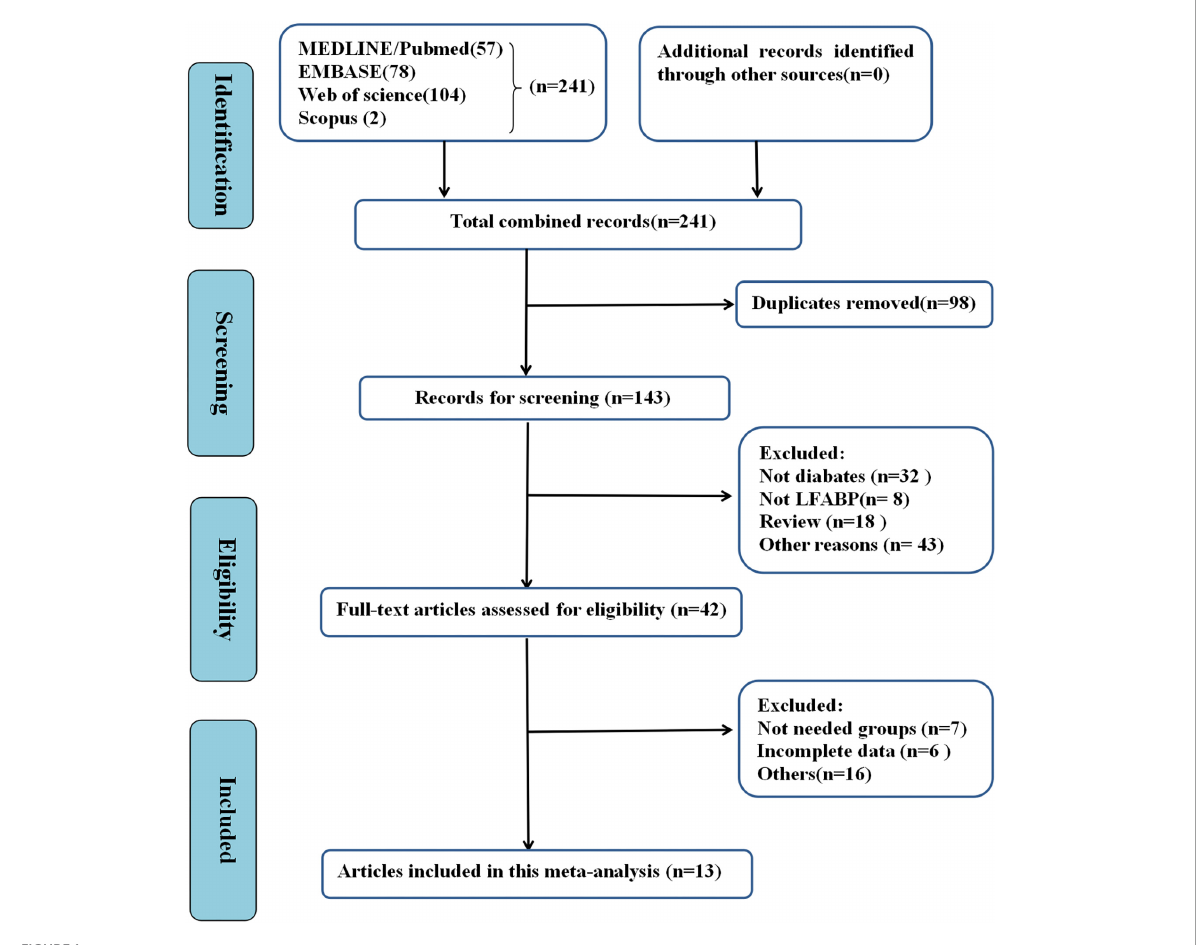
FIGURE1 Flow chart of screening